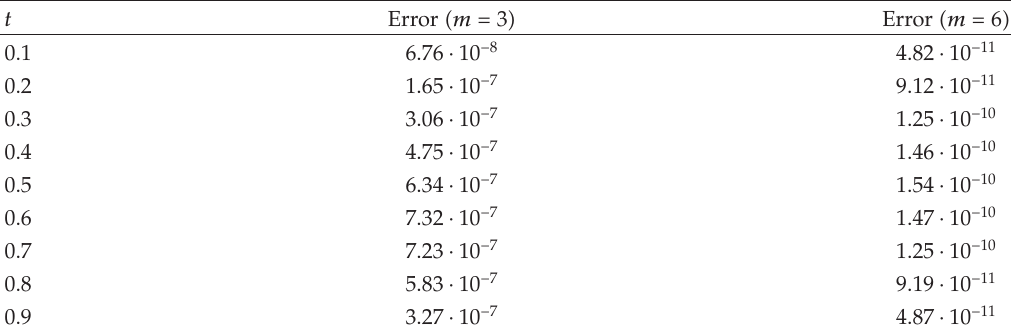
Table 6: Problem (cid:4) 5.7 (cid:5) —Example 5.6.